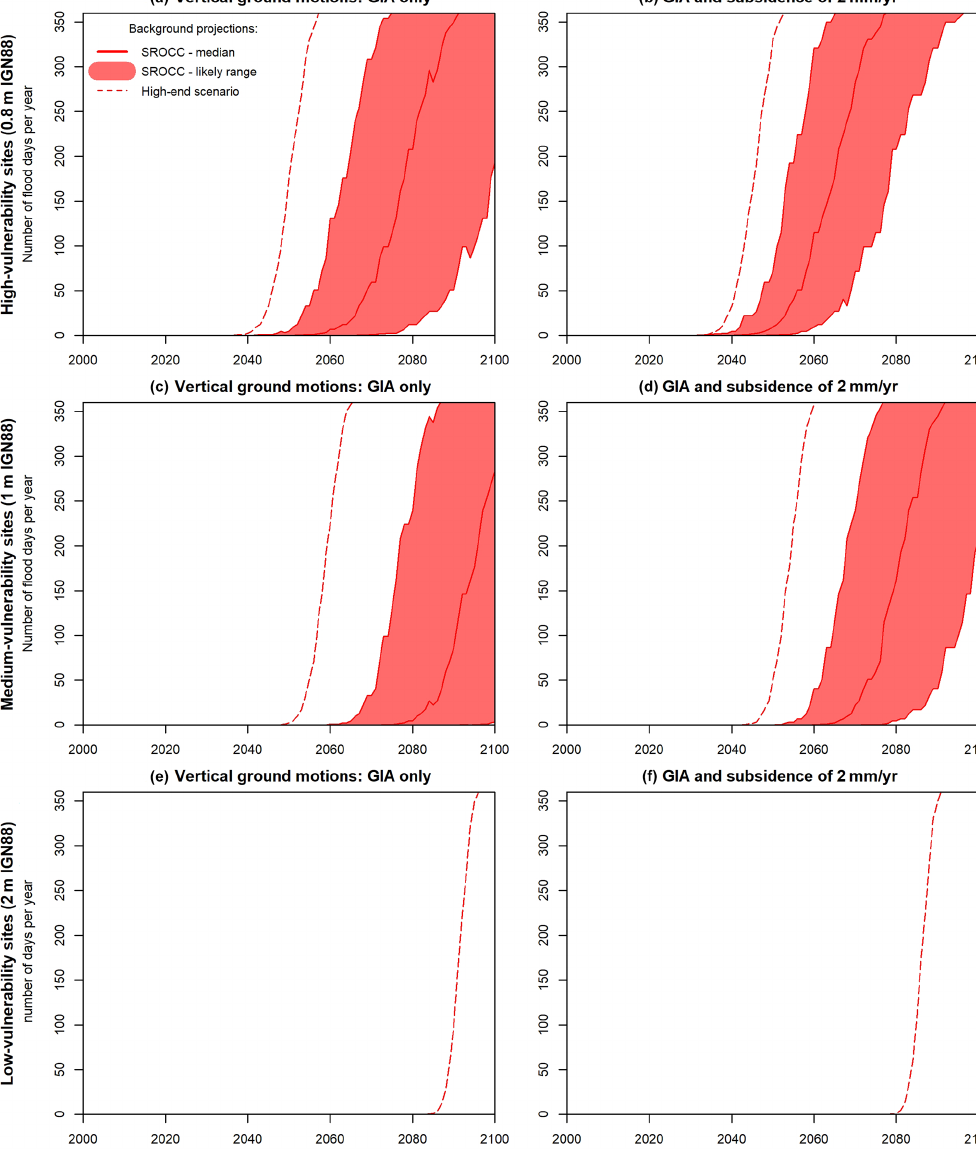
Figure 7. Reconstruction and projections of chronic flooding events, for two subsidence scenarios and three idealized types of coastal sites in Jarry and Pointe-à-Pitre. The color code is the same as in Fig.